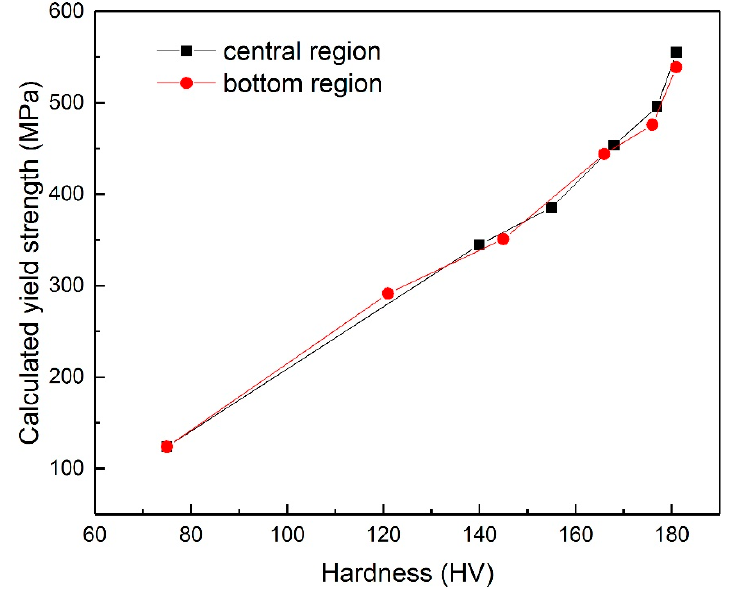
Figure 8. Relationship between the calculated yield strength and the measured hardness in the central and bottom regions of the ECAPed Cu-Mg alloy. and bottom regions of the ECAPed Cu-Mg